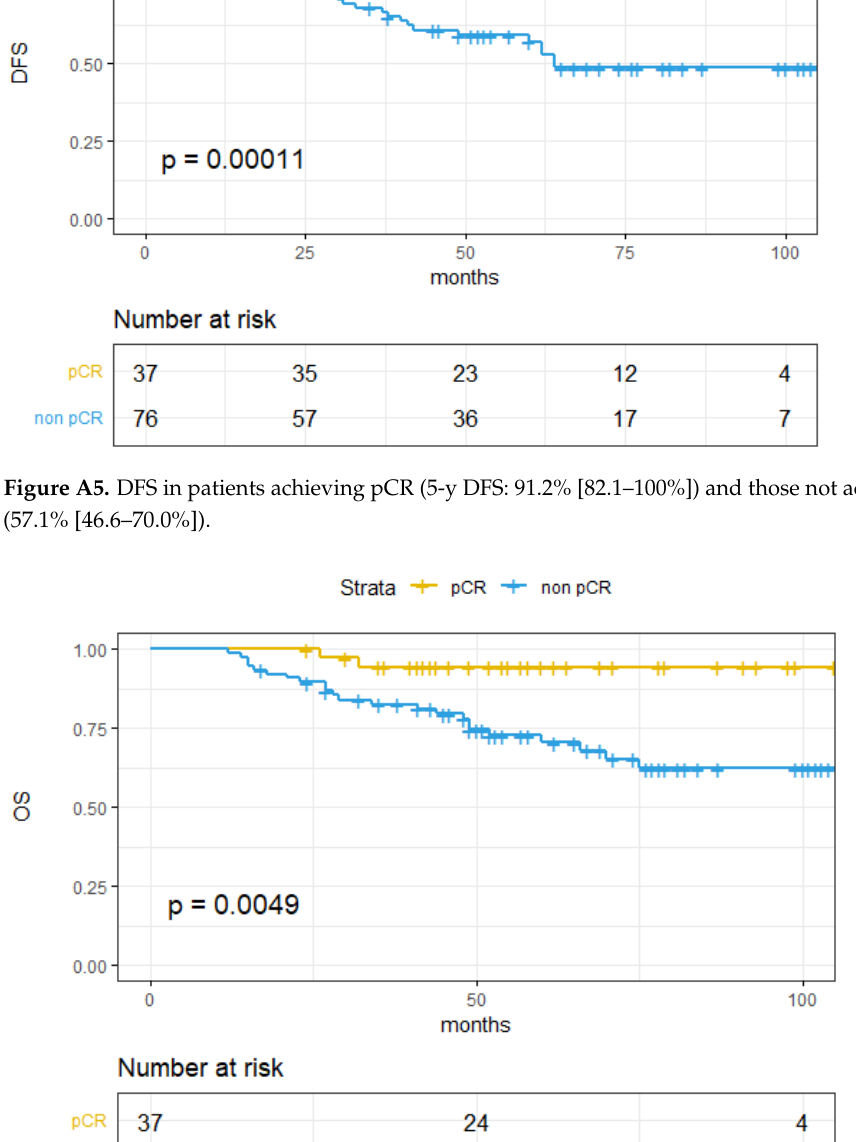
Figure A6. OS in patients achieving pCR (5-y OS: 94.4% [87.1–100%]) and those not achieving pCR (70.5% [59.9–82.3%]).